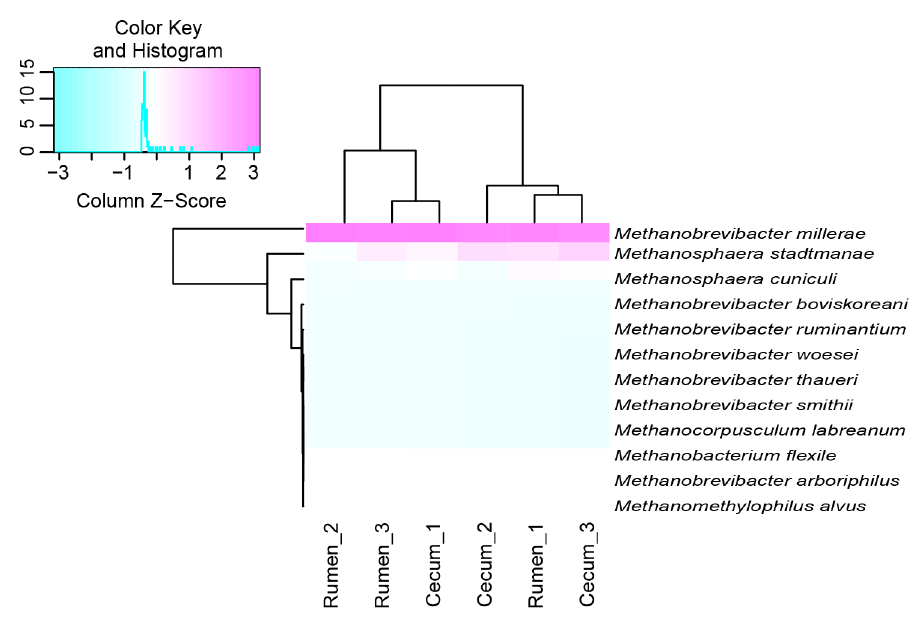
Figure 7. Heatmap analysis showing the distributions of methanogens communities in the rumen and cecum of three roe deer. OTU, operational taxonomic units.